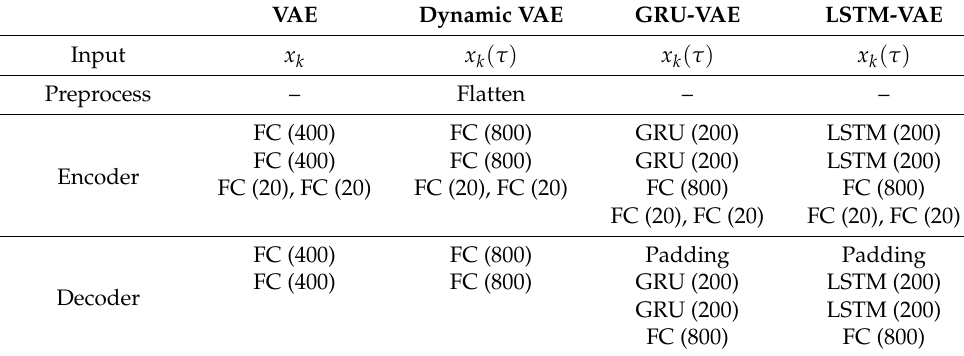
Table 1. Deep architectures for all VAE